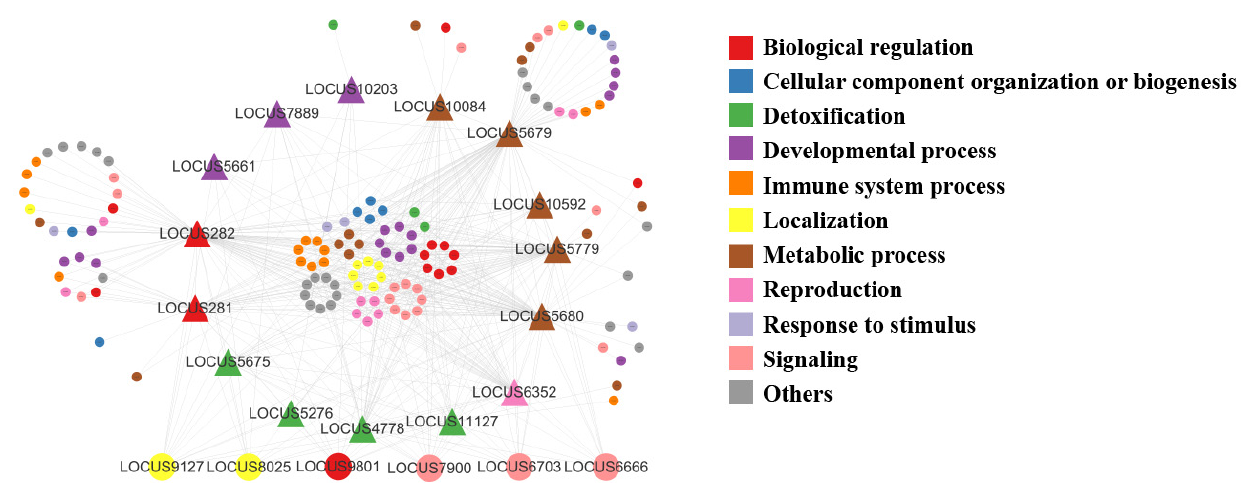
Figure 9. Gene co-expression pattern network developed using Cytoscape3.9.1. Different colors represent different pathways, and the larger circles represent transcription factors.